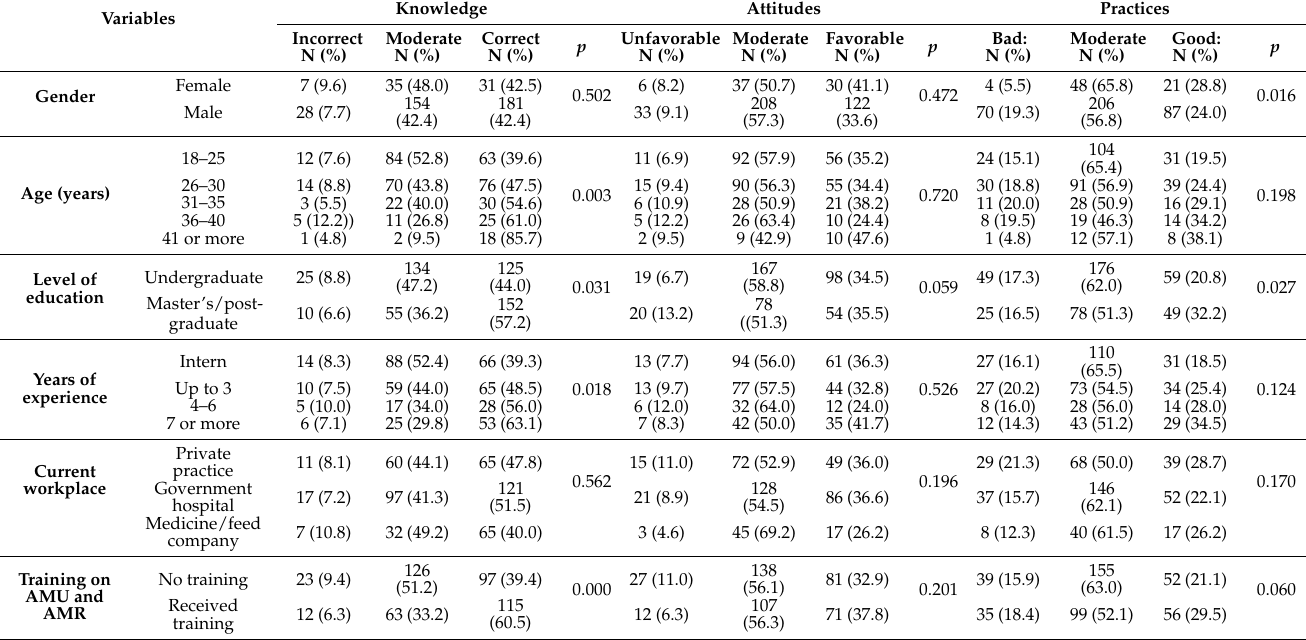
Table 5. Test of statistical significance of variation in the respondents’ knowledge on AMU and AMR by their